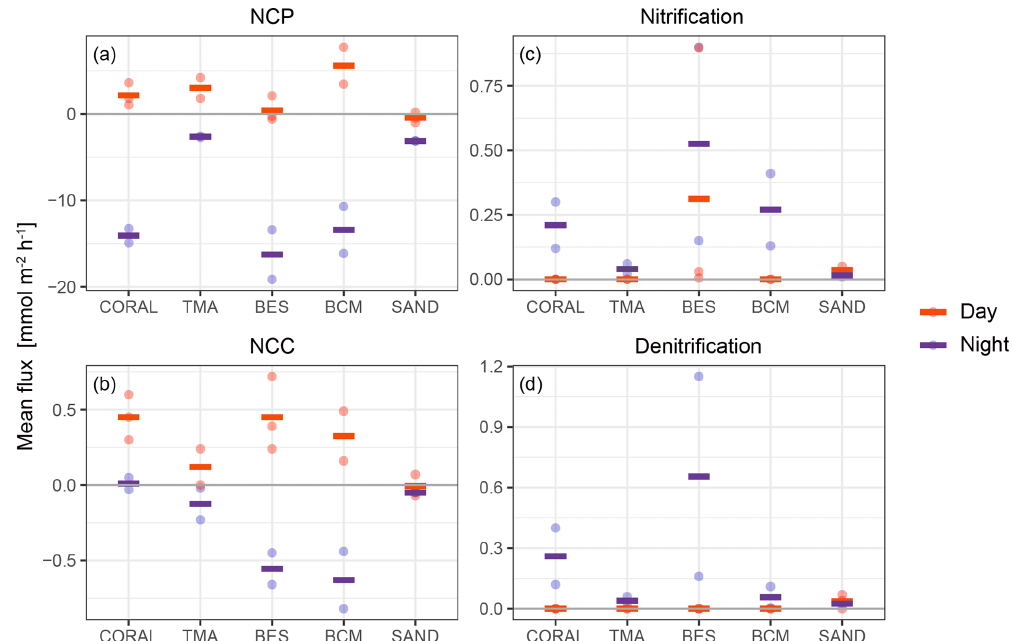
Figure 6. Process rates for all tent replicates (points) and respective averages (line) estimated from observed concentration changes and model output in the tent enclosure on each substrate type. Processes occurring during the day are depicted in red, and processes at night are represented in